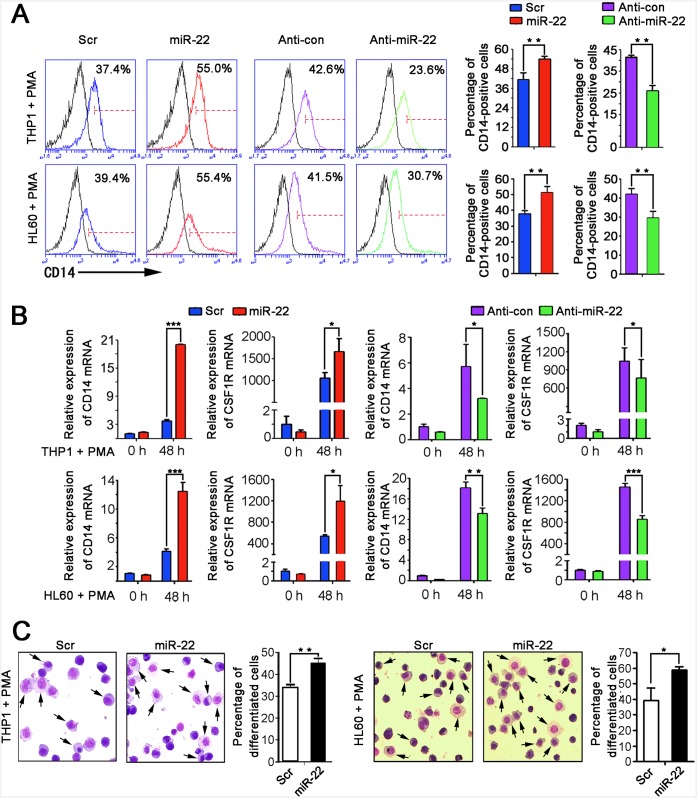
miR-22 promotes PMA-induced monocyte/macrophage differentiation of THP1 and HL60 cells.A. The percentage of CD14-positive cells in the transfected cells was analyzed by flow cytometry. The cells were transfected with miR-22 mimics, miR-22 inhibitors, or negative control (Scr or Anti-Con). Twenty-four hours post-transfection, the cells were treated with PMA for another 48 hours. A representative experiment is presented on the left and a statistical analysis of three independent experiments is displayed on the right. The black-line curve represents the unstained cells. Error bars represent SD (n = 3). (**P<0.01, Student’s t-test). B. The relative expression of CD14 and CSF1R was measured by qRT-PCR in the transfected cells before and after PMA treatment for 48 hours. Error bars represent SD (n = 3). (*P<0.05, **P<0.01, ***P<0.001, Student’s t-test). C. May–Grünwald Giemsa staining indicated that ectopic expression of miR-22 promoted maturation of monocytes/macrophages in THP1 and HL-60 cells. The cells were observed under 400 X magnification. The arrows point to differentiated monocytes/macrophages. A statistical analysis of differentiated monocytes/macrophages in five fields is presented in the right. Error bars represent SD. (*P<0.05, **P<0.01, Student’s t-test).